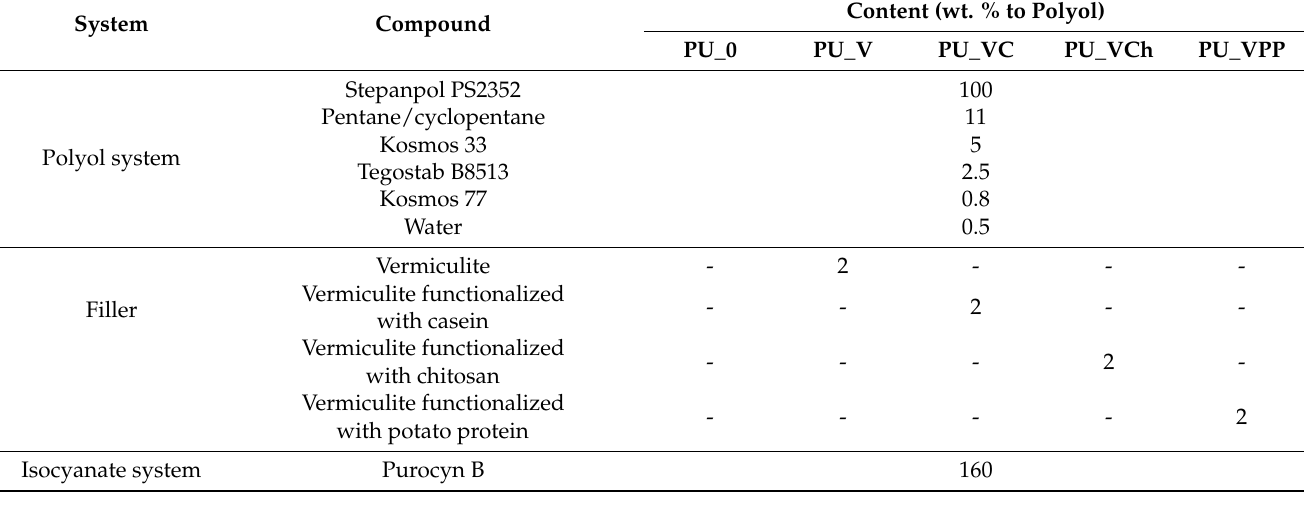
Table 5. Composition of polyurethane foams.